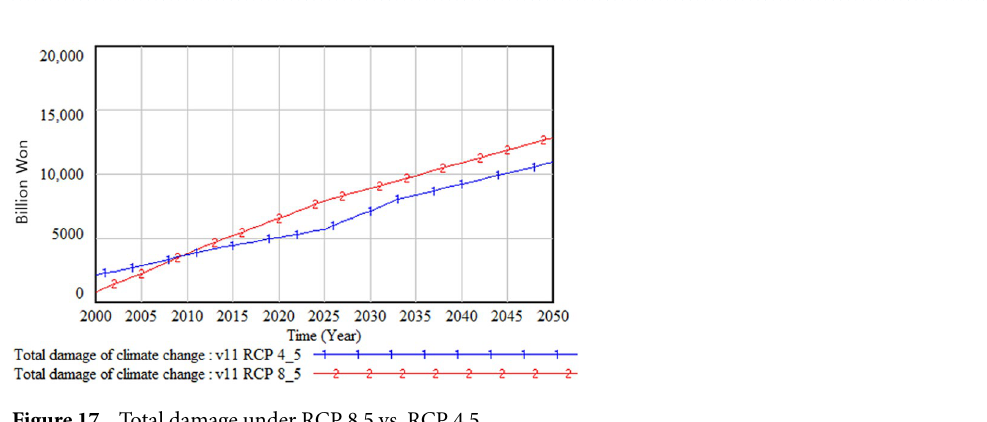
Figure 16. Social and environmental damage under RCP 8.5 vs. RCP 4.5.